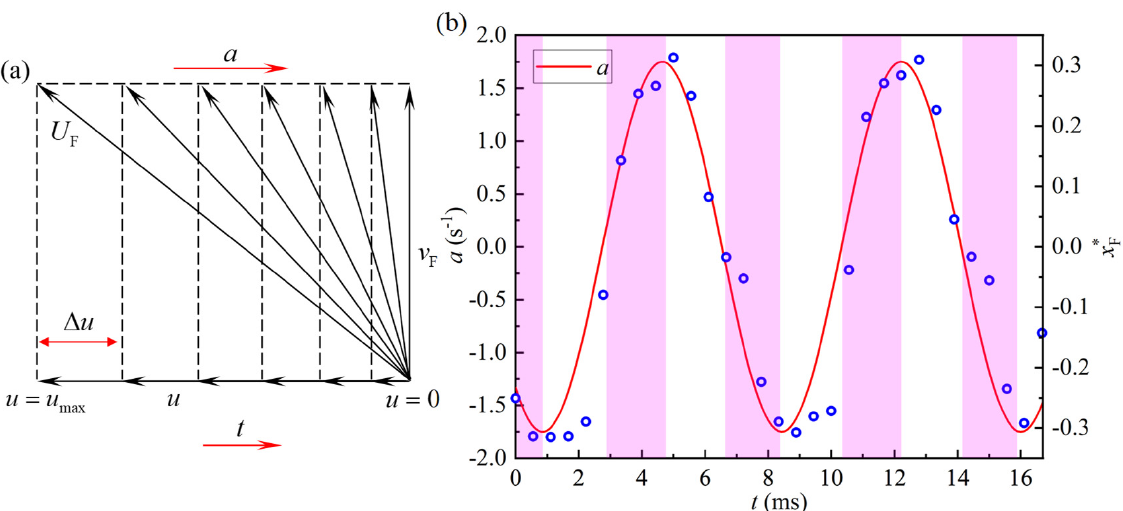
x of the experiment and the curve of the U ; ( b ) * of the experiment and the curve of the F F F